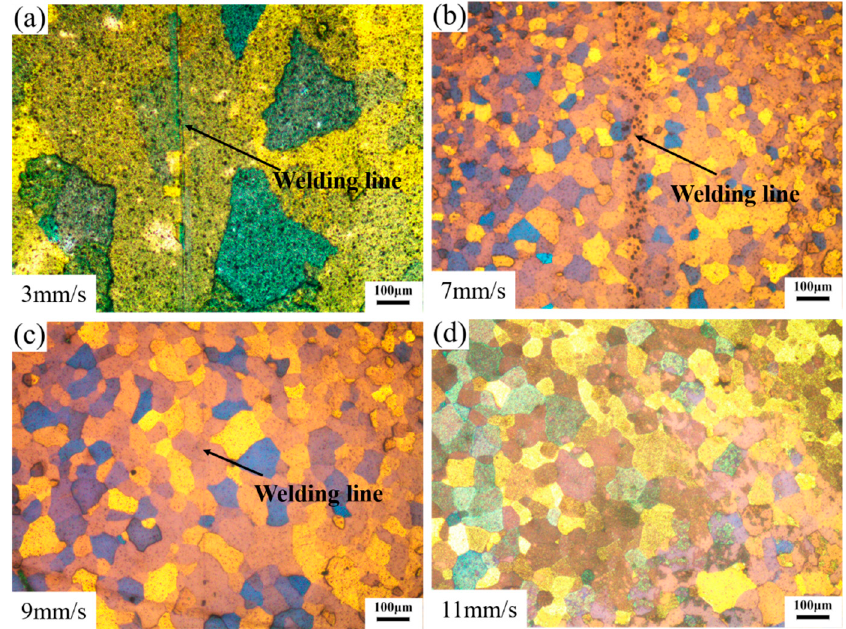
Figure 7. Microstructures of the welding zones on the transverse cross-section. ( a – d ) different ram speed.